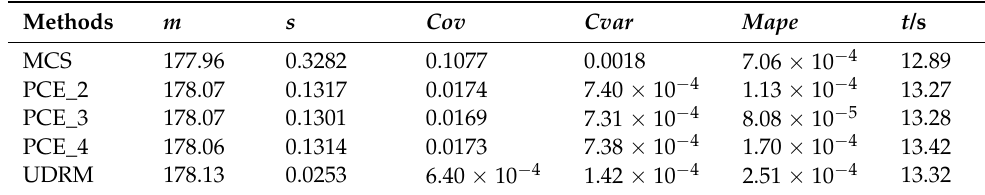
Table 7. Evaluation table of different UQ methods under 50% uncertainty of sheath resistivity under short-circuit fault.